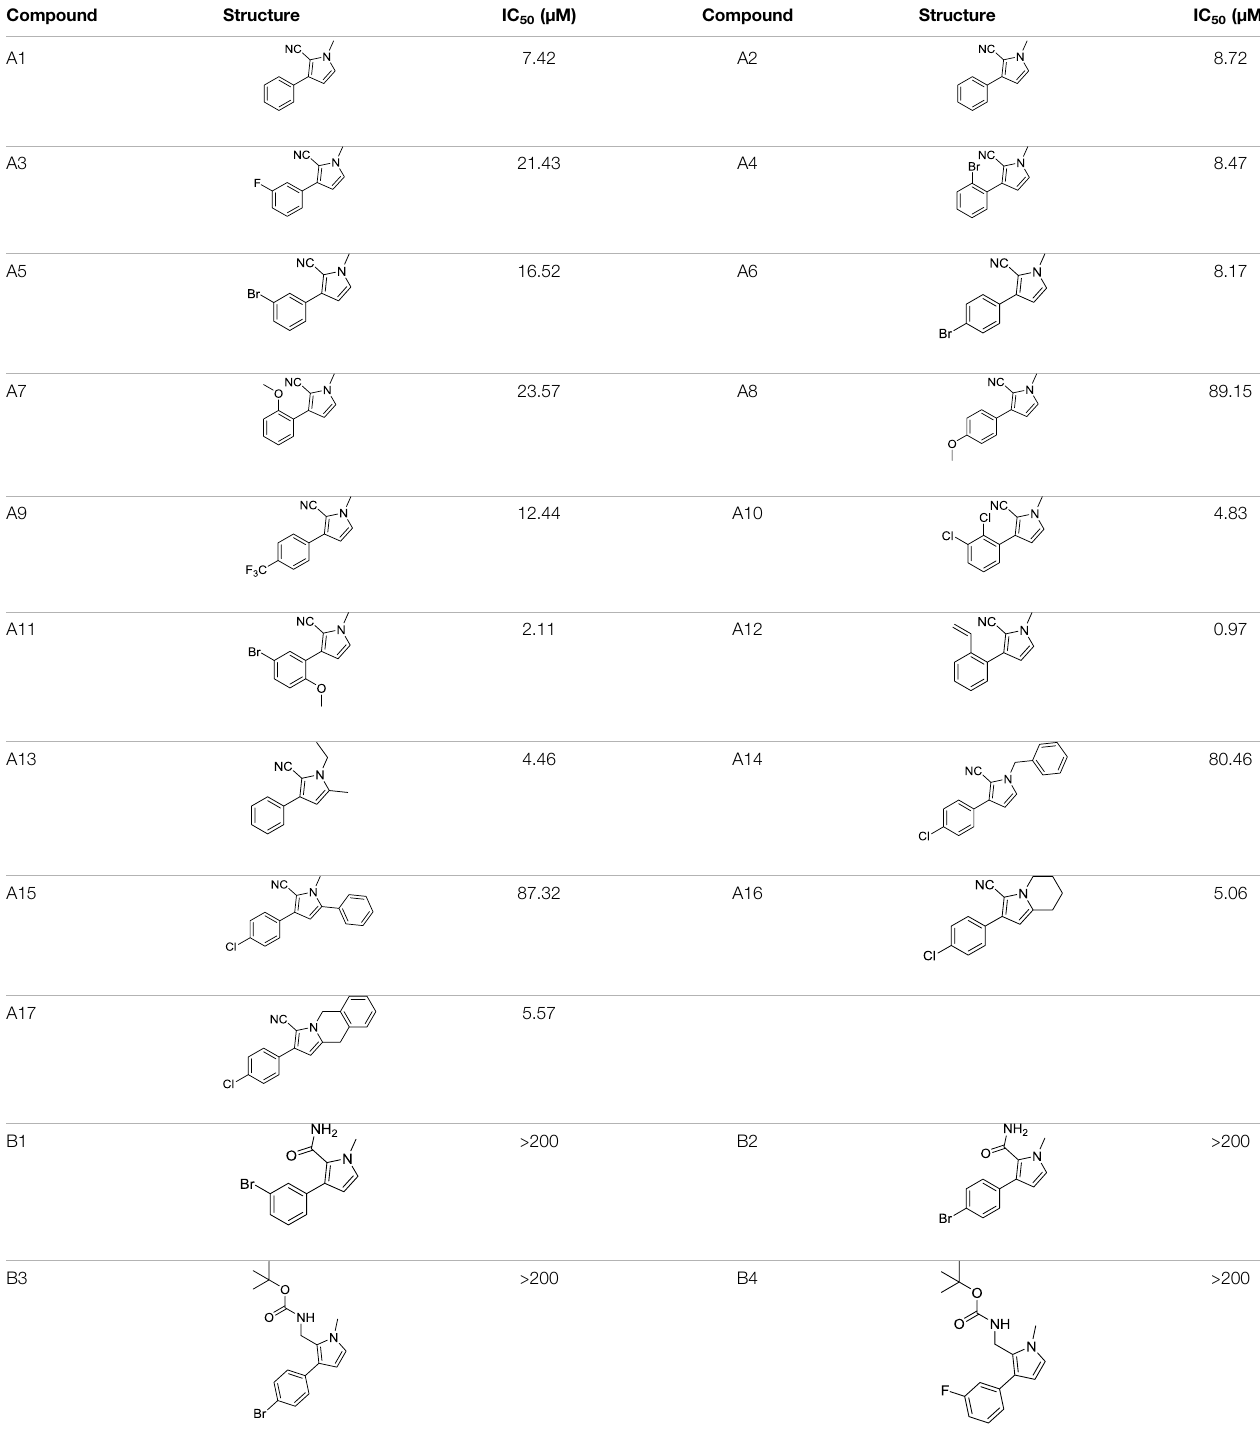
TABLE 1 | Inhibitory activity of N-heterocycle derivatives on